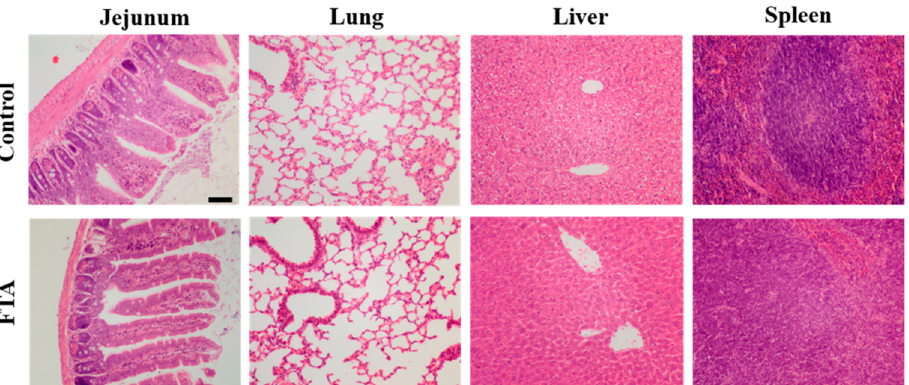
Figure 4. Effects of FTA on the organs of mice. Histopathological changes are observed in the jejunum, lung, liver, and spleen of the mice from each group. Scale bars, 100 μ m. Data from three independent experiments and error bars are presented as the mean ± SEM.